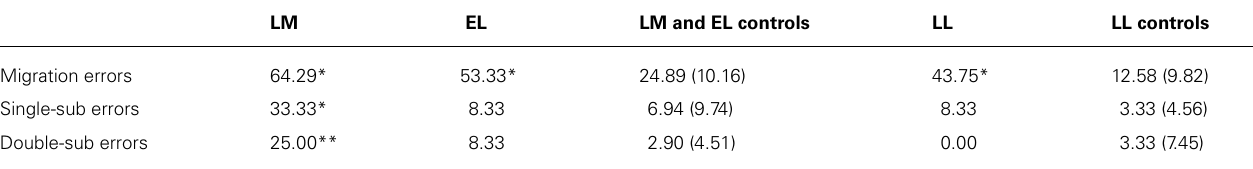
Table 3 | Percentage of migration errors, single-substitution (sub) errors and double-substitution (sub) errors on the visual lexical decision task.